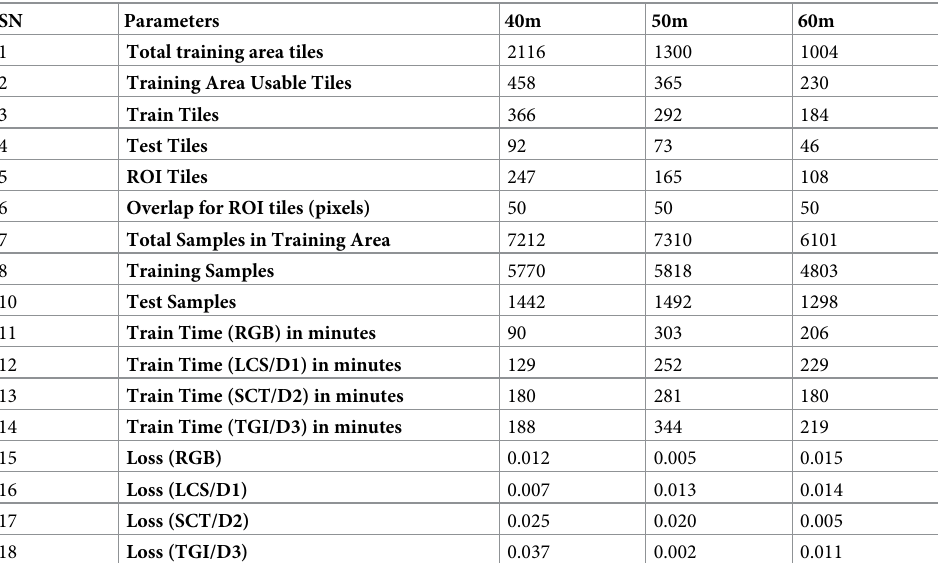
Table 3. Training details of altitude variants.